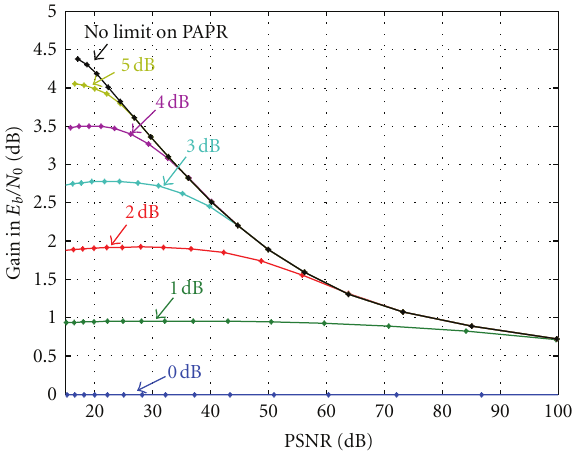
Figure 4: Improvement in the PSNR of power optimized 16-QAM when compared with conventional 16-QAM.